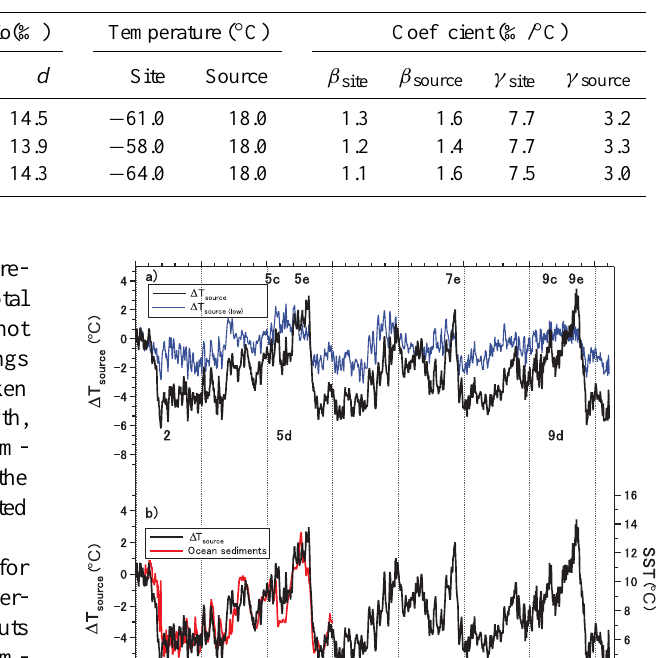
Table 3. Test of β site sensitivity to the super saturation function.